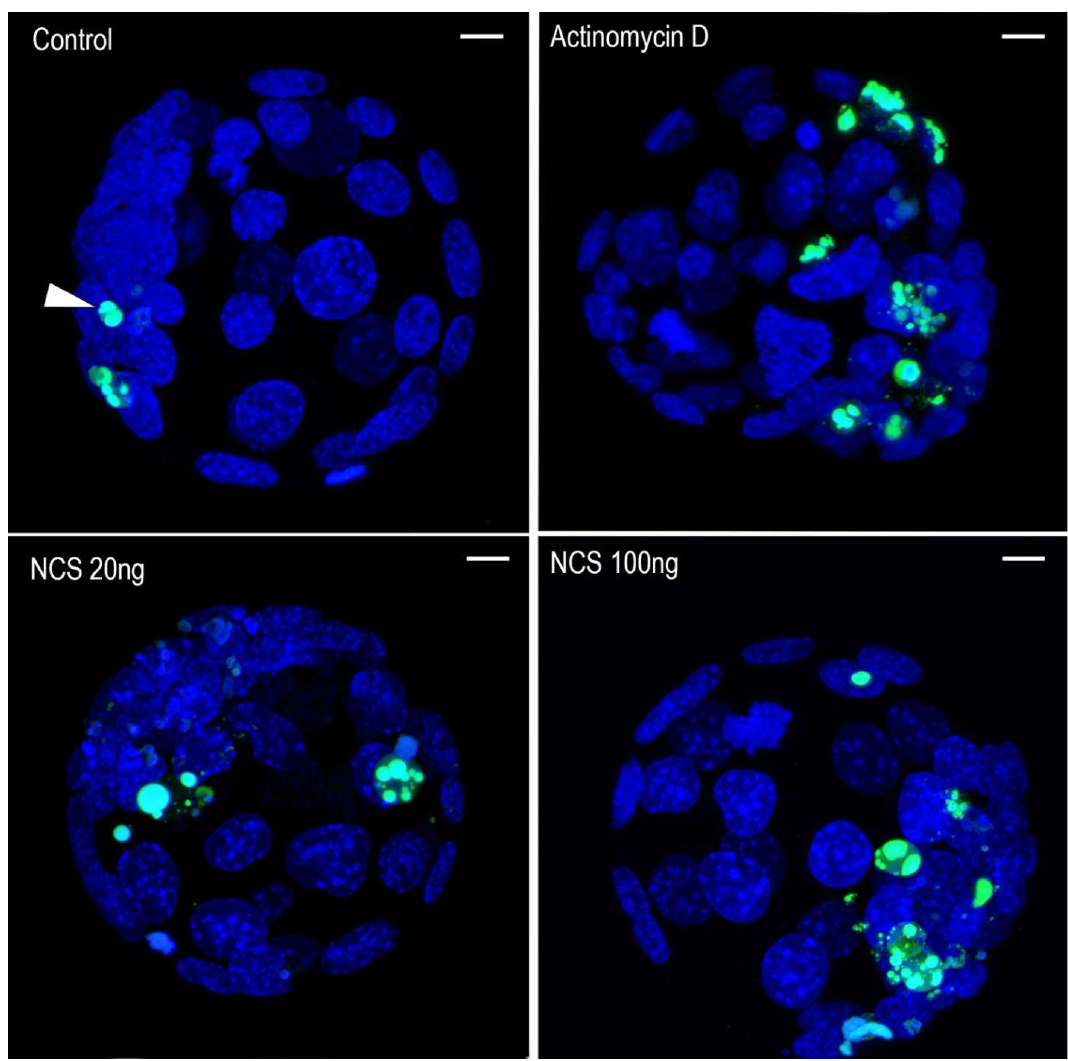
Figure 13. DNA degradation visualized by TUNEL staining (green—arrowhead) in mouse blastocysts. DAPI staining (blue) shows nuclei of blastomeres. That Z-stack projections of the serial confocal sections across whole blastocysts are shown. Scale bar = 10µm.